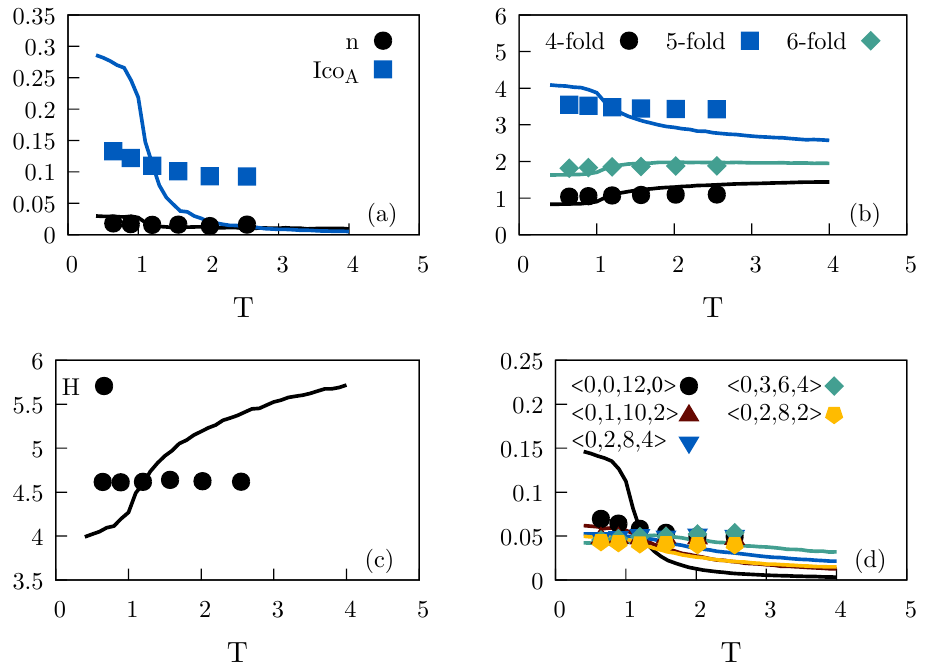
Figure 4. Different higher-order structure measures along an isomorph and along the isochore of Figure 3a, plotted as functions of the temperature for the Wahnström binary LJ mixture. The solid lines represent values along the ρ = 0.85 isochore, while the points give values along the isomorph generated from the reference state point ( ρ , T ) = ( 0.85,1.2 ) (Figure 3b). ( a ) shows results for the occurrence of Frank–Kasper bonds (black, denoted by “ n ”) and small particles in icosahedral local order (blue, denoted by “Ico A ”). ( b ) shows the average number of four-, five-, and six-sided faces of the Voronoi polyhedra. ( c ) shows the Shannon entropy of the cell types of the Voronoi tessellation (Equation (6)). ( d ) shows the relative frequency of occurrence of the five most common Voronoi cell types. Overall, there is good isomorph